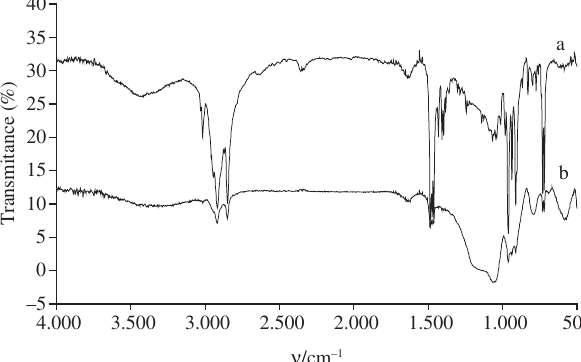
Figure 1. IR spectra: a) sol-gel; and b) sol-gel functionalised with 15% of MPTMS.